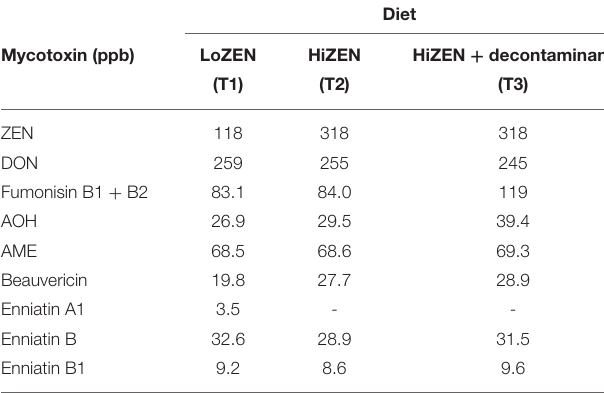
TABLE 2 | Multi-mycotoxin analyses of the diets (levels in ppb).